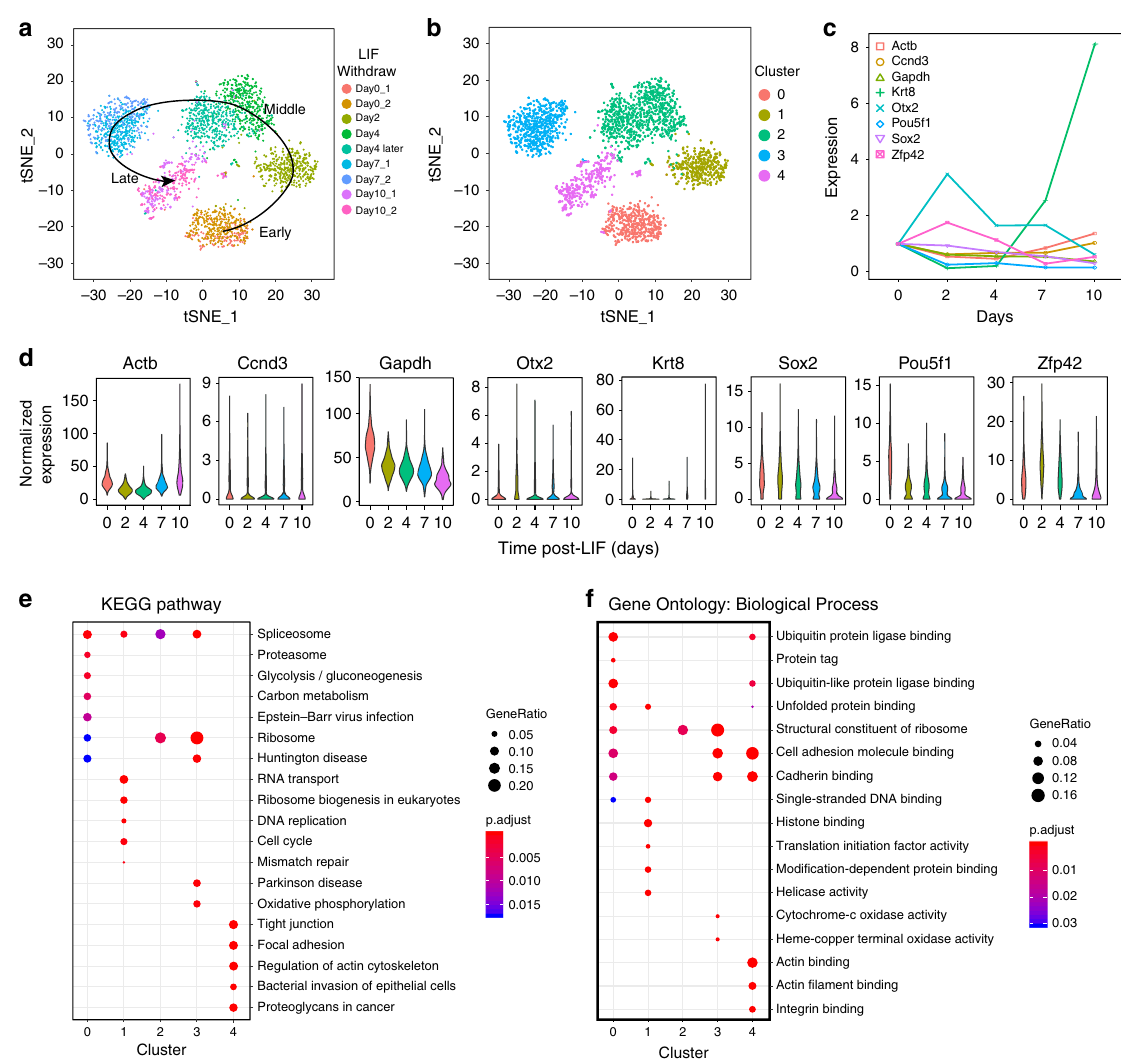
Fig. 5 Heterogeneity of differentiated mouse ES cells. a t-SNE maps of mES samples from different days after LIF withdrawal. Different experimental batches are labeled with different colors. b t-SNE maps of mES samples by unsupervised clustering ID. Five distinct clusters are labeled with different colors. c Average and d distribution of key pluripotent factors and differentiated markers of different time points after LIF withdrawal. e KEGG pathway enrichment analysis for fi ve clusters. f Biological process analysis of gene ontology enrichment for fi ve clusters Source data are provided as a Source Data fi